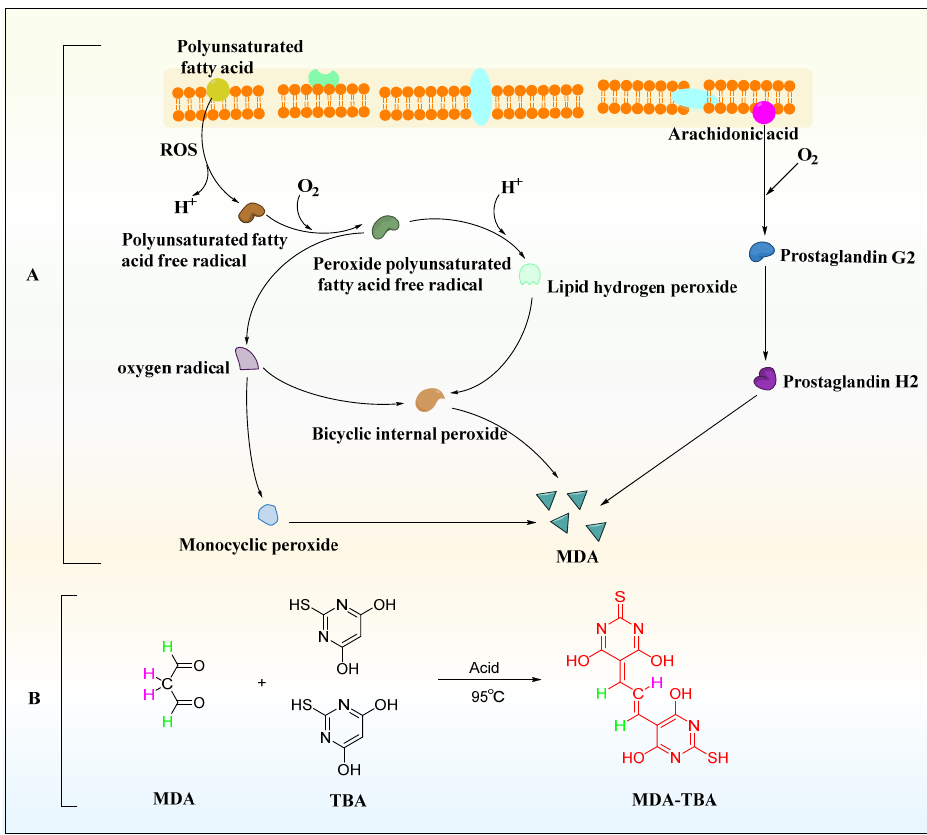
Figure 5. MDA generation and detection method. ( A ) MDA production process. ( B ) Thiobarbituric acid assay.